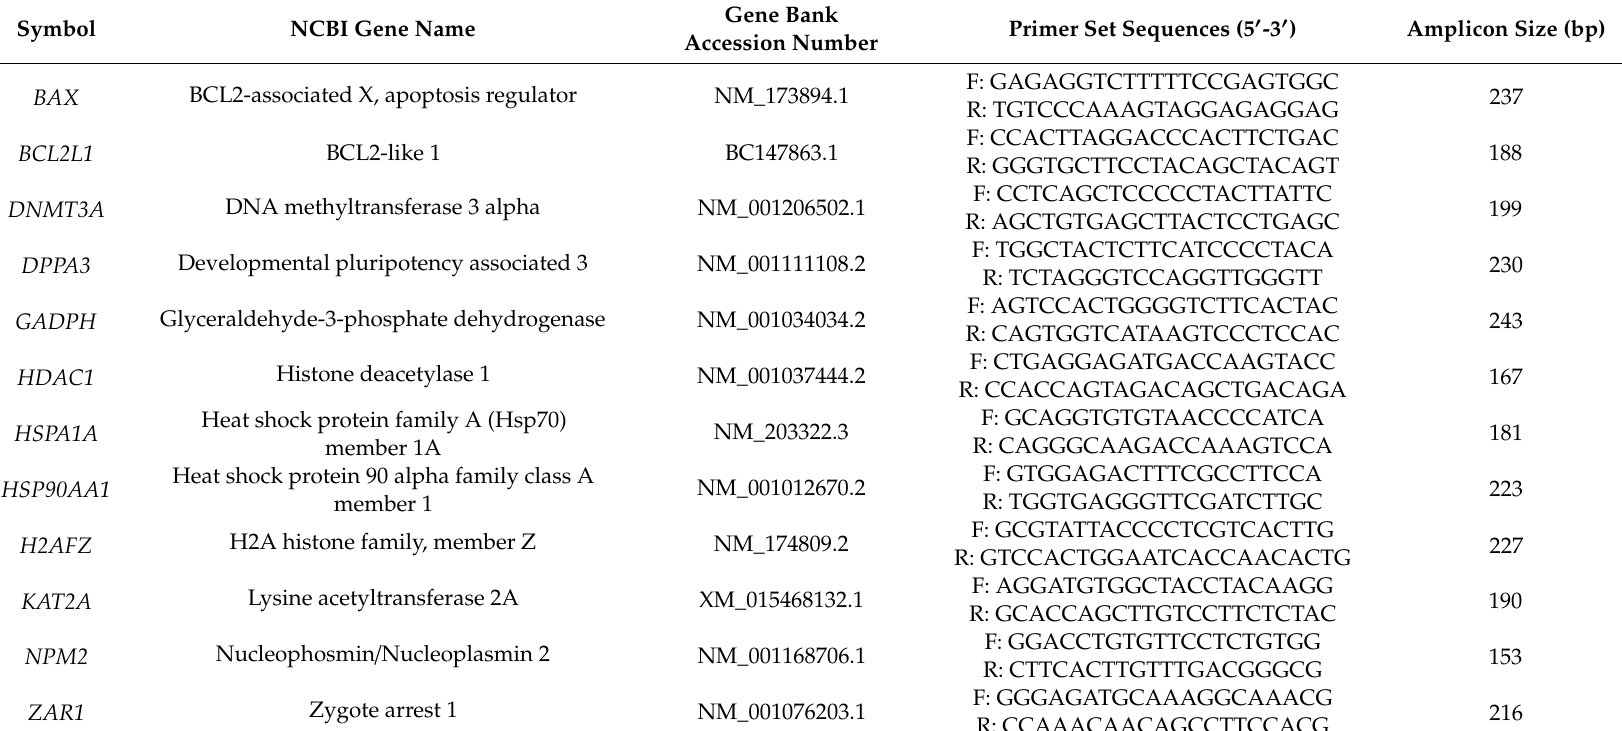
Table 3. Primers used for reverse transcription–quantitative polymerase chain